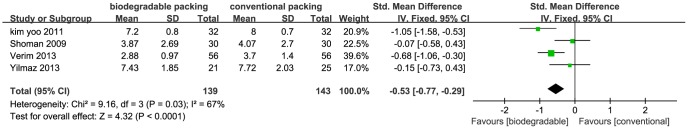
Forest plot of comparison: nasal blockage (biodegradable packings versus conventional packings).